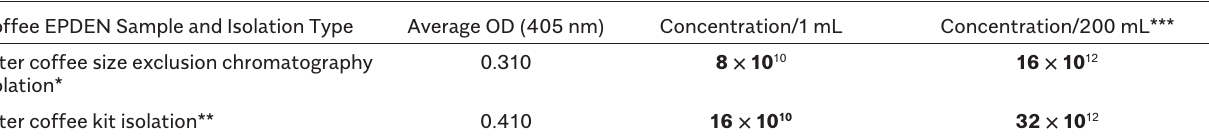
Table 1. Quantitation Kit Optimal Density (405 nm) Results and Concentrations of Coffee EPDENs in Different Volumes and Diluted in Different Proportions Coffee EPDEN Sample and Isolation